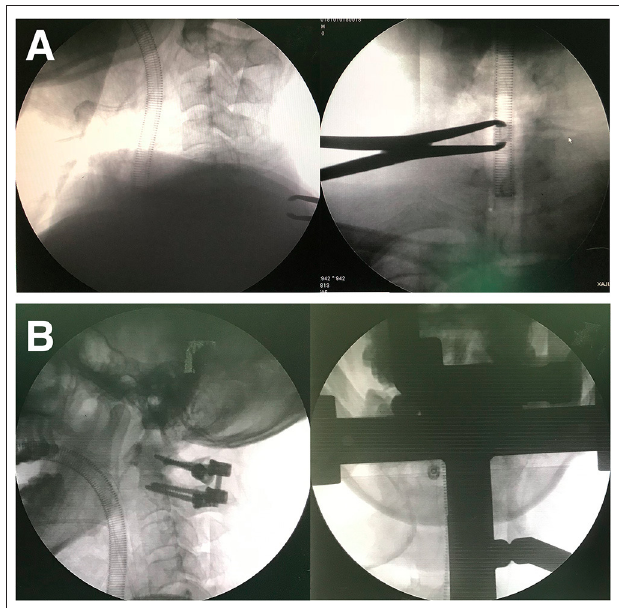
FIGURE 5 | Anterior-posterior intro-operation radiography is available in BSPST position benefit from X-ray penetrable characteristics of plaster (A,B)